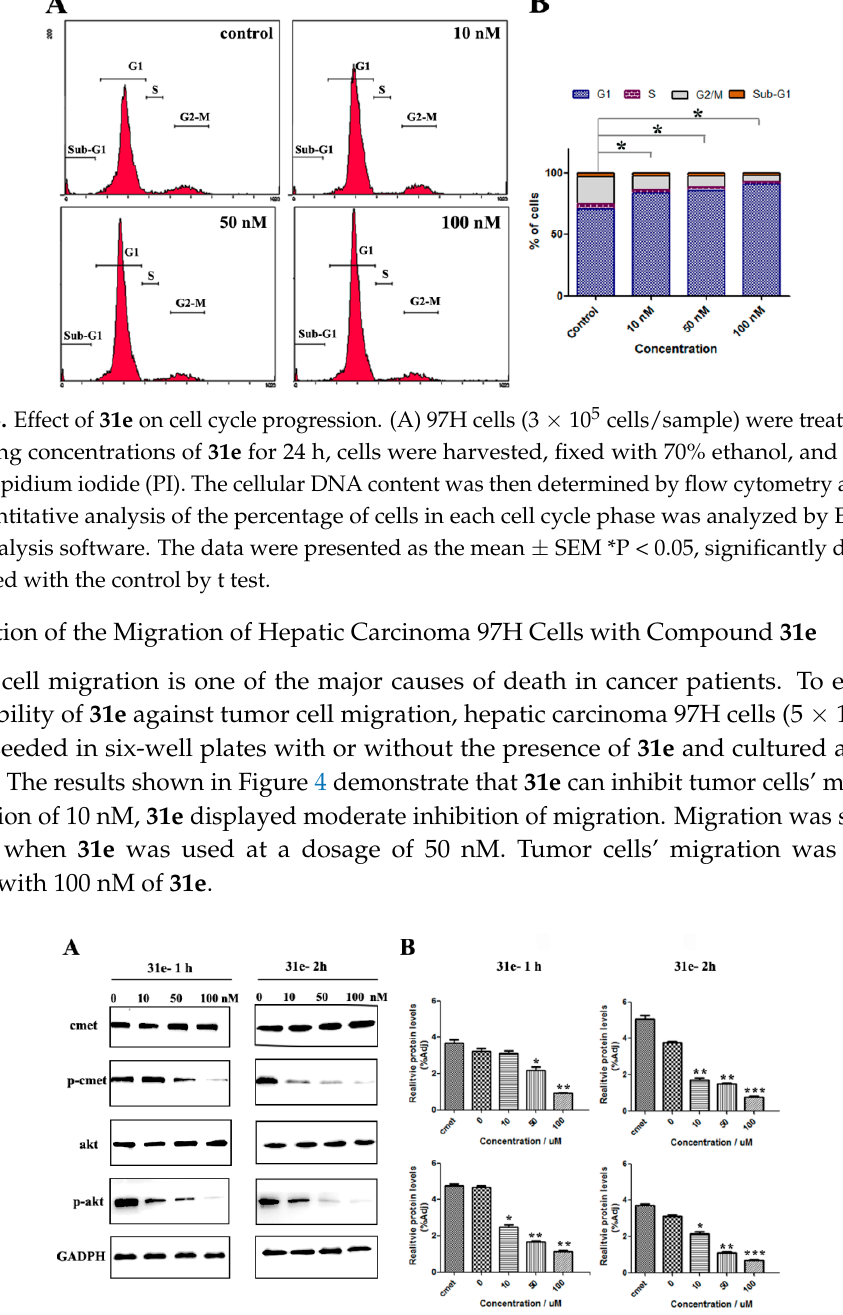
Figure 4. Effect of 31e on the migration of hepatic carcinoma 97H cells. Hepatic carcinoma 97H cells (50 × 10 4 cells) suspended in free serum Dulbecco's Modified Eagle Medium (DMEM) containing 31e for 36 h were photographed under a phase contrast microscopy (magnification: 4 × objective). All results were expressed as the mean ± SD of at least three independent